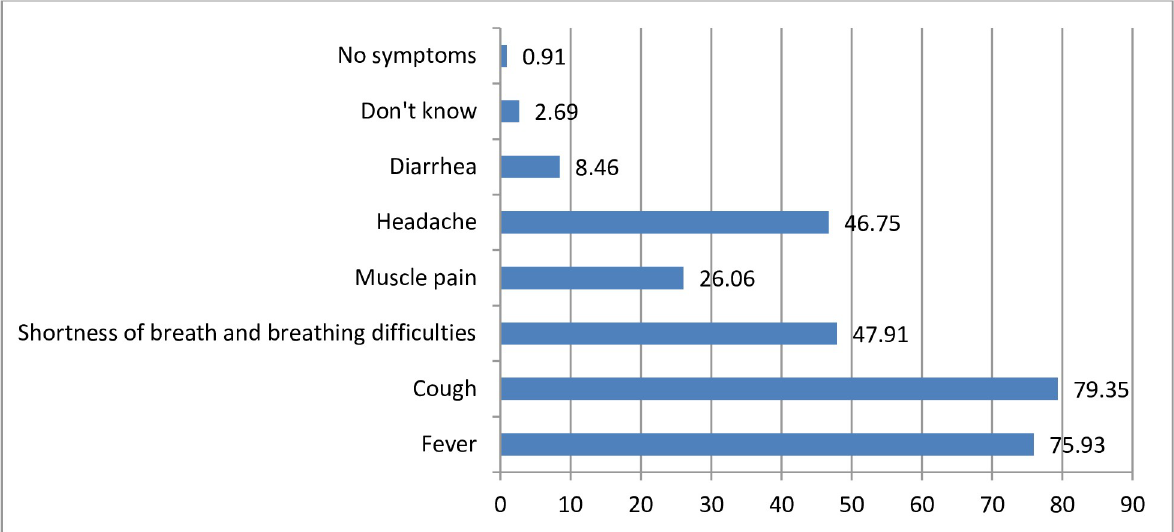
Fig 8. Percentage of the symptoms of COVID-19 mentioned by the respondents, Oromia region, Ethiopia, September 2020 to March 2021. NB: Percentage may not add 100% as multiple responses were possible.